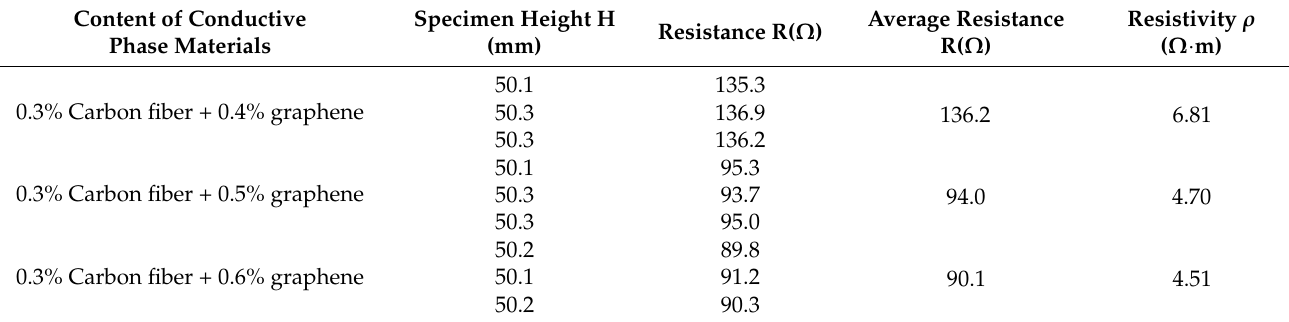
Table 17. Resistance test results of externally attached copper electrode rut plate